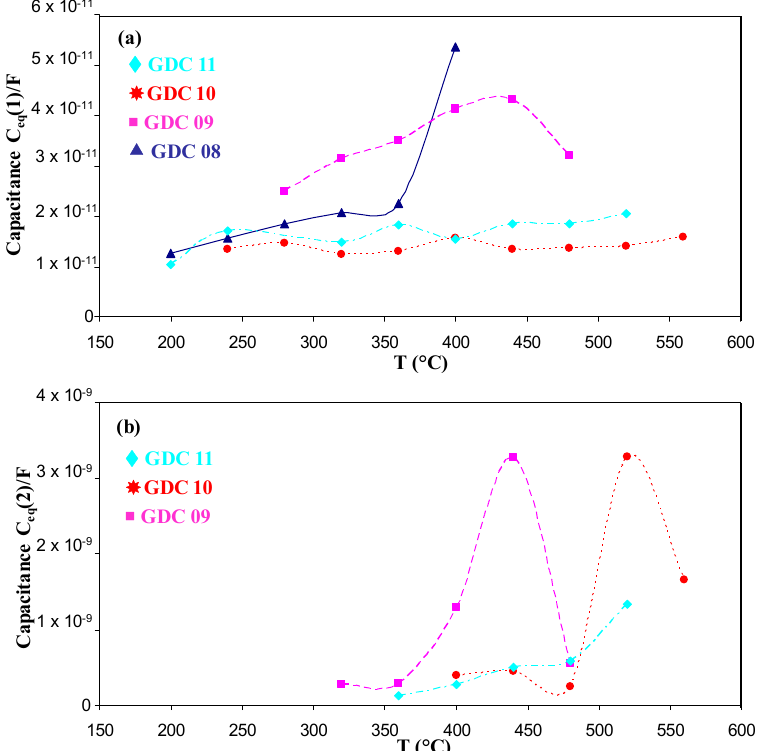
Figure 7. Equivalent capacitance as a function of the temperature for the first ( a ) and the second contribution ( b ).